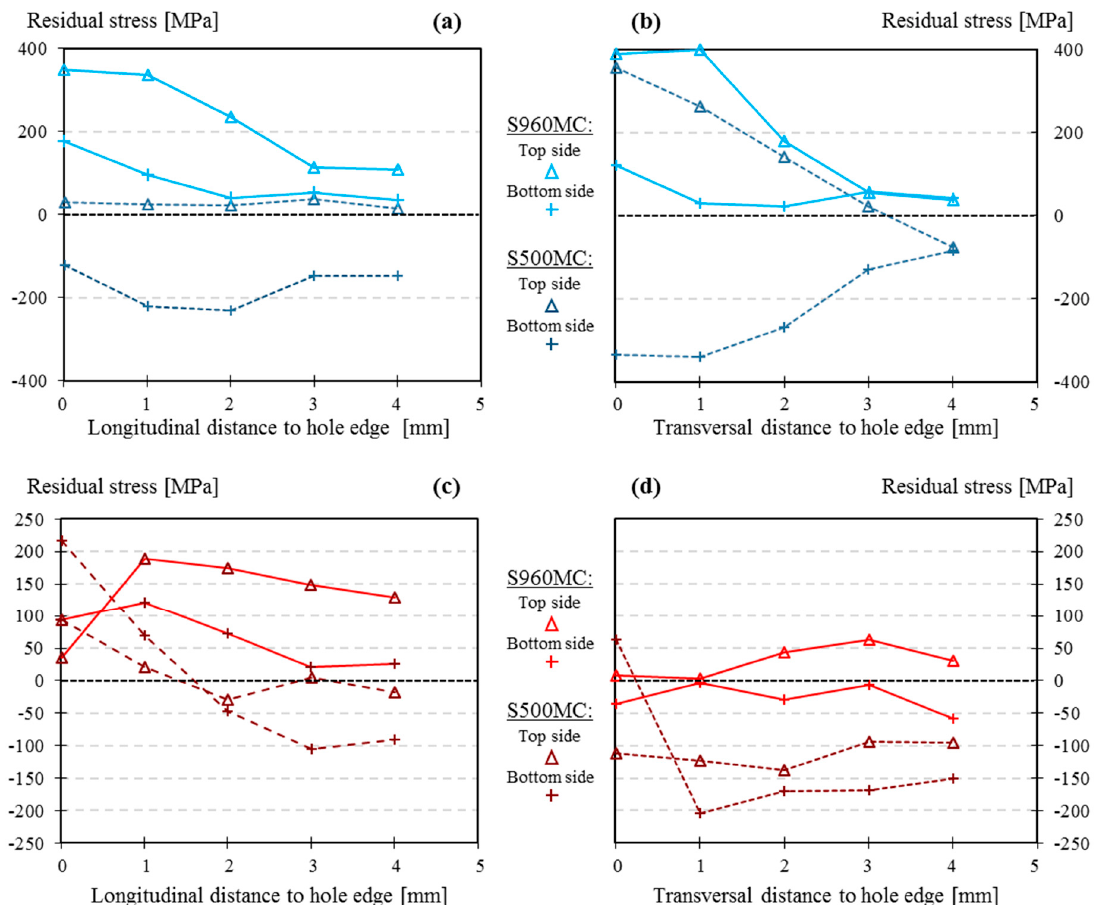
Figure 16. Residual stresses of punched S500MC and S960MC specimens in the ( a ) longitudinal and ( b ) transverse direction, and of laser-cut S500MC and S960MC specimens in the ( c ) longitudinal and ( d ) transverse direction. Here, error bars are smaller than the markers and are, therefore, not shown. Connecting lines between measurement positions are for guidance of the eye only.